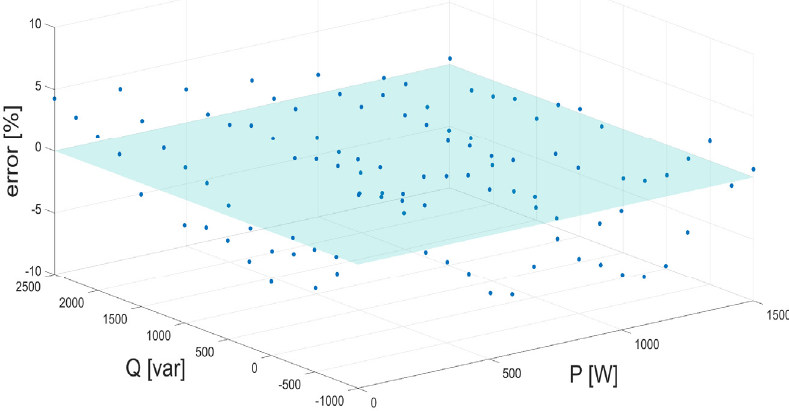
Figure 16. Experimental results. Healthy theoretical model relative errors (%) with respect to the actual measurements collected from healthy condition tests, for different [P,Q] operating points at rated output voltage ( U = 400 V ).